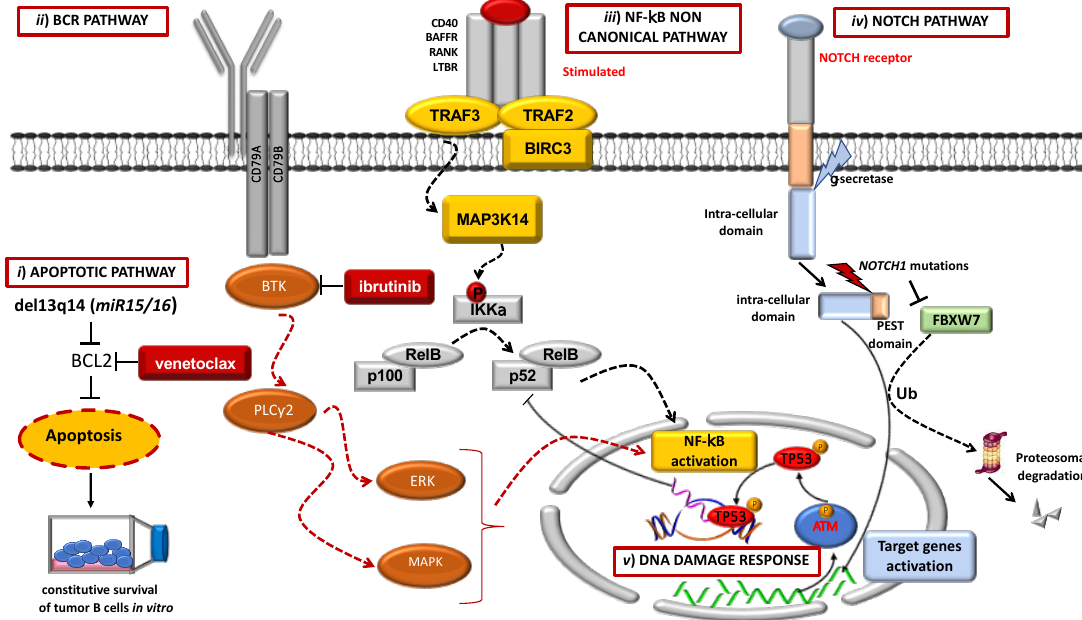
Figure 1. Biological pathways involved in chronic lymphocytic leukemia (CLL) pathogenesis and harboring therapeutic implications. (i) Venetoclax (in red) binds and inhibits the BCL2 anti-apoptotic protein, which is frequently impaired by a variety of molecular mechanisms (e.g., del13q14), thus restoring the apoptosis in CLL cells. (ii) Bruton's tyrosine kinase (BTK), a pivotal kinase located downstream to the BCR pathway, can be targeted by BTK inhibitors such as ibrutinib (in red). (iii) The activation of the non-canonical NF- κ B pathway contributes to cell survival and progression. (iv) Notch homolog 1 (NOTCH1) mutations disrupt the PEST domain (in orange) of the NOTCH intracellular domain (NICD), leading to constitutive transcription of target genes promoting survival and proliferation. (v) The nuclear TP53 and Ataxia telangiectasia mutated (ATM) proteins are involved in the DNA damage response pathway.